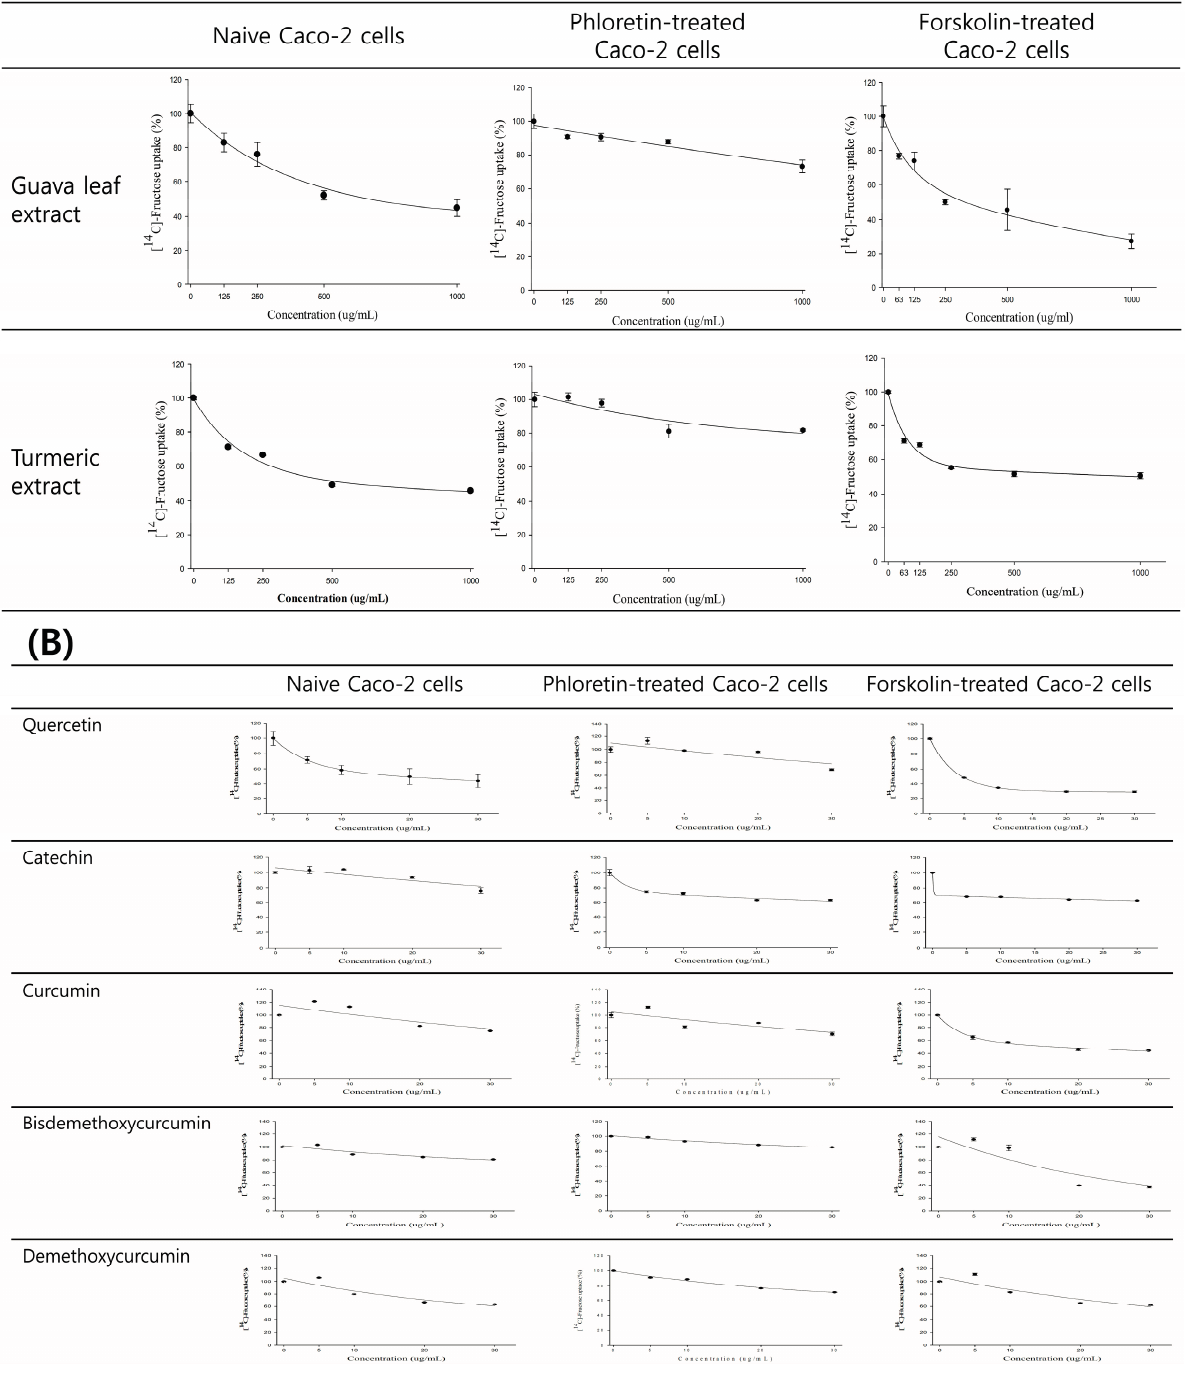
Figure 4. Inhibition of fructose uptake by guava leaf extract and turmeric extract ( A ) and their signature components ( B ) in naive, phloretin-treated and forskolin-treated Caco-2 cells. Cells were incubated in 10 mM [ 14 C] fructose with increasing concentrations of samples for 10 min. Transport was determined by scintillation spectrometry. Values represent the mean ±